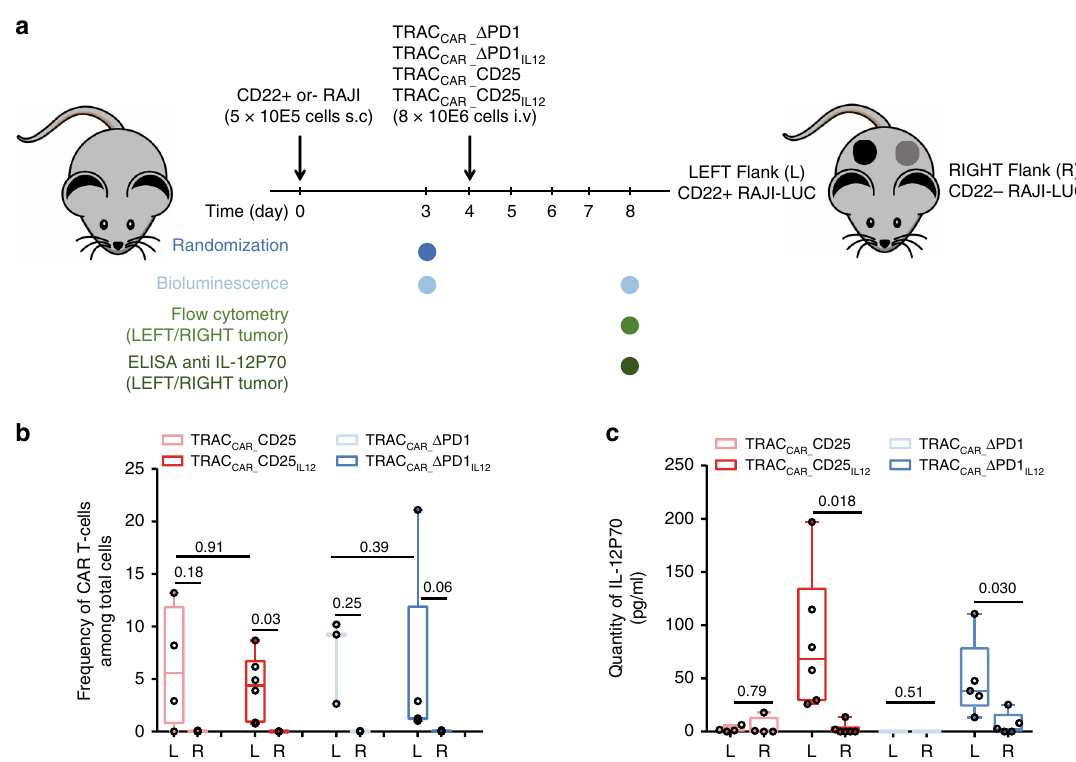
Fig. 5 In vivo local and tumor-dependent delivery of IL-12P70 by TRAC CAR T cells. a Schematic showing the experimental design to study the tumor- dependent secretion of IL-12P70 by TRAC CAR T cells in NSG mice (BLI: bioluminescence). CD22( + ) and CD22( − ) RAJI tumor cells expressing fi re fl y luciferase were transferred subcutaneously into the left (L) and right (R) fl anks of NSG mice, respectively, and allowed to engraft for 4 days before TRAC CAR T cell transfer. Four days after TRAC CAR T cells transfer, tumors and T cells were recovered, dissociated, and analyzed via fl ow cytometry and ELISA. b Frequency of TRAC CAR T cells detected by fl ow cytometry at the left (L) and right (R) fl anks of NSG mice. A non parametric paired Mann-Whitney test was used for statistical analysis of the data ( p -value are indicated). c Quantity of IL-12P70 detected in the left (L) and right (R) fl anks of NSG mice. Each point documented in b and c represents the result obtained in each mice ( n = 4 for TRAC CAR _CD25, n = 6 for TRAC CAR _CD25 IL12 , n = 3 for TRAC CAR _ Δ PD1, n = 5 for TRAC CAR _ Δ PD1 IL12 ). On each box plot, the central mark indicates the median, the bottom and top edges of the box indicate the interquartile range (IQR) and the whiskers represent the maximum and minimum data point. A paired Wilcoxon-Mann-Whitney non-parametric test was used for statistical analysis of the IL-12P70 quantities obtained at the right and left fl anks of the same animal (p-value are indicated). Source data are provided as a Source Data fi